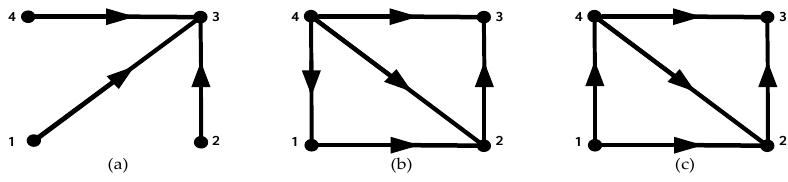
Figure 10. Directed Frameworks ( a ) Not Rigid ( b ) Not Persistent ( c ) Persistent